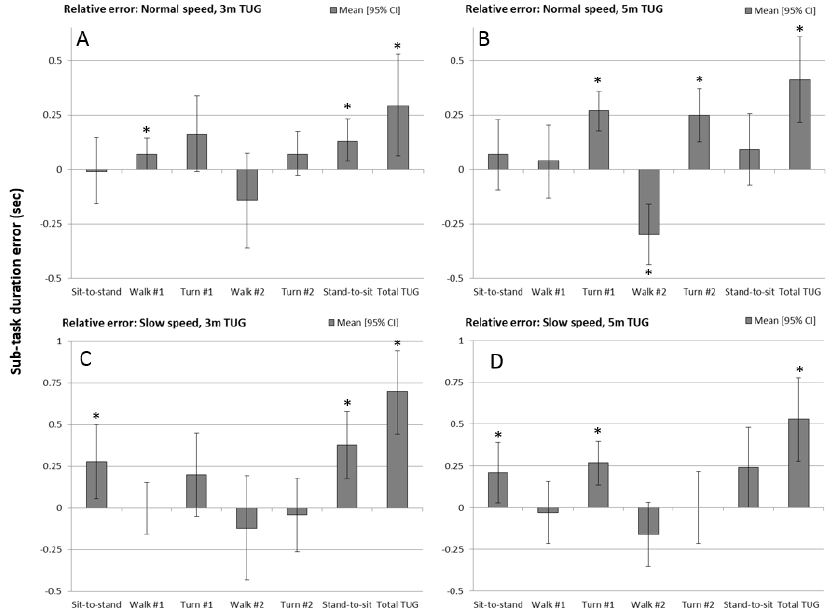
Figure 4. Relative error between the marker-based and IMU-based measurement systems for sub-task phases and the total TUG time, for each of the four experimental conditions: ( A ) 3 m normal speed; ( B ) 5 m normal speed; ( C ) 3 m slow speed, and; ( D ) 5 m slow speed. Whiskers represent the 95% confidence intervals on the mean error and the asterisk indicates error that was significantly different from zero ( p <